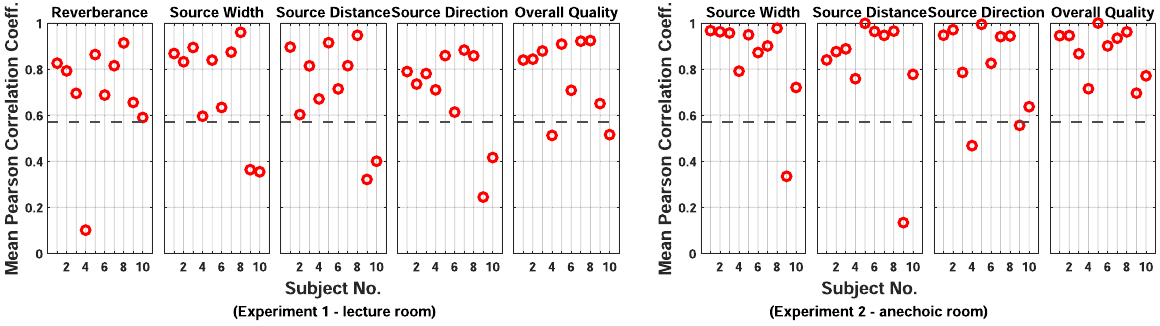
Figure 5. Mean Pearson correlation coef fi cients r for the three presentation pairs (1 – 2, 1 – 3, 2 – 3) as a measure for consistent ratings. The dashed horizontal line indicates the chosen lower threshold for r . Subjects with a r below this threshold were excluded from the evaluations. To calculate the correlations coef fi cients, 32 combinations (4 loudspeaker positions (cid:1) 8 BRIR sets) for Experiment 1 and 18 combinations (3 loudspeaker positions (cid:1) 6 BRIR sets) for Experiment 2 were considered for each of the three presentation pairs.